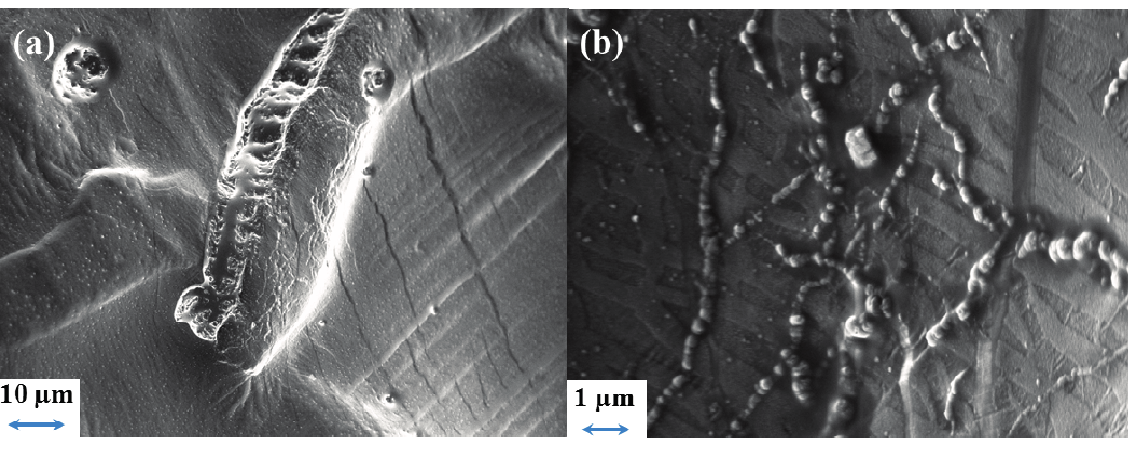
Figure 12. SEM images of the Li surface after 100 cycles, using a 10 mol% LiTFSI PYR TFSI and a Freudenberg FS2190 separator. 14